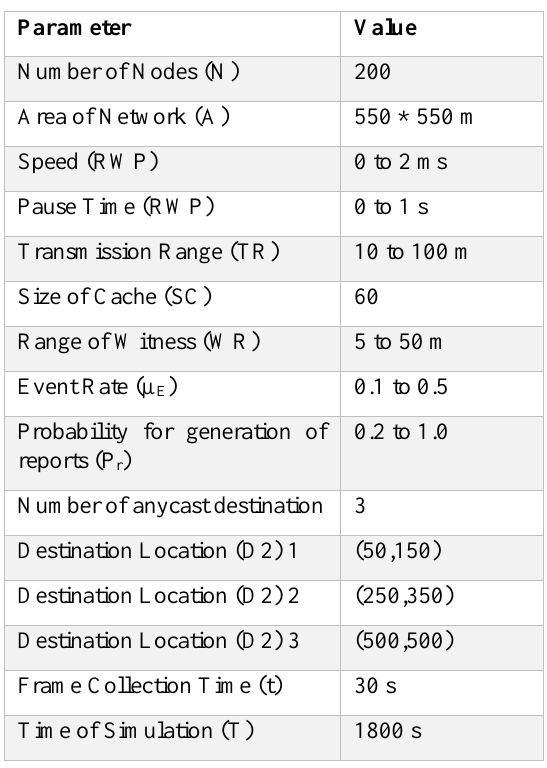
Table 1. Simulation parameters and its